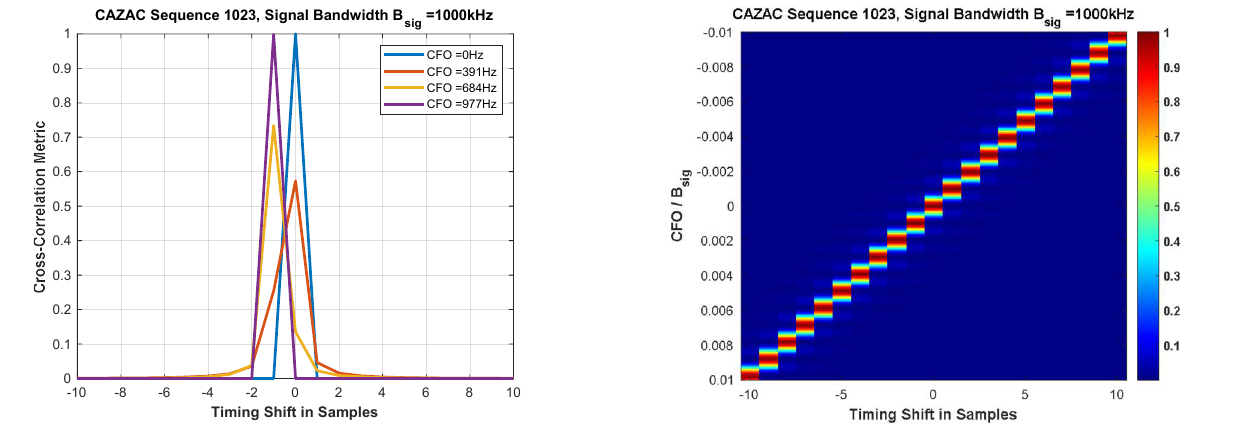
Figure 8. Cross-correlation performance of a single CAZAC sequence used for time–frequency synchronization.